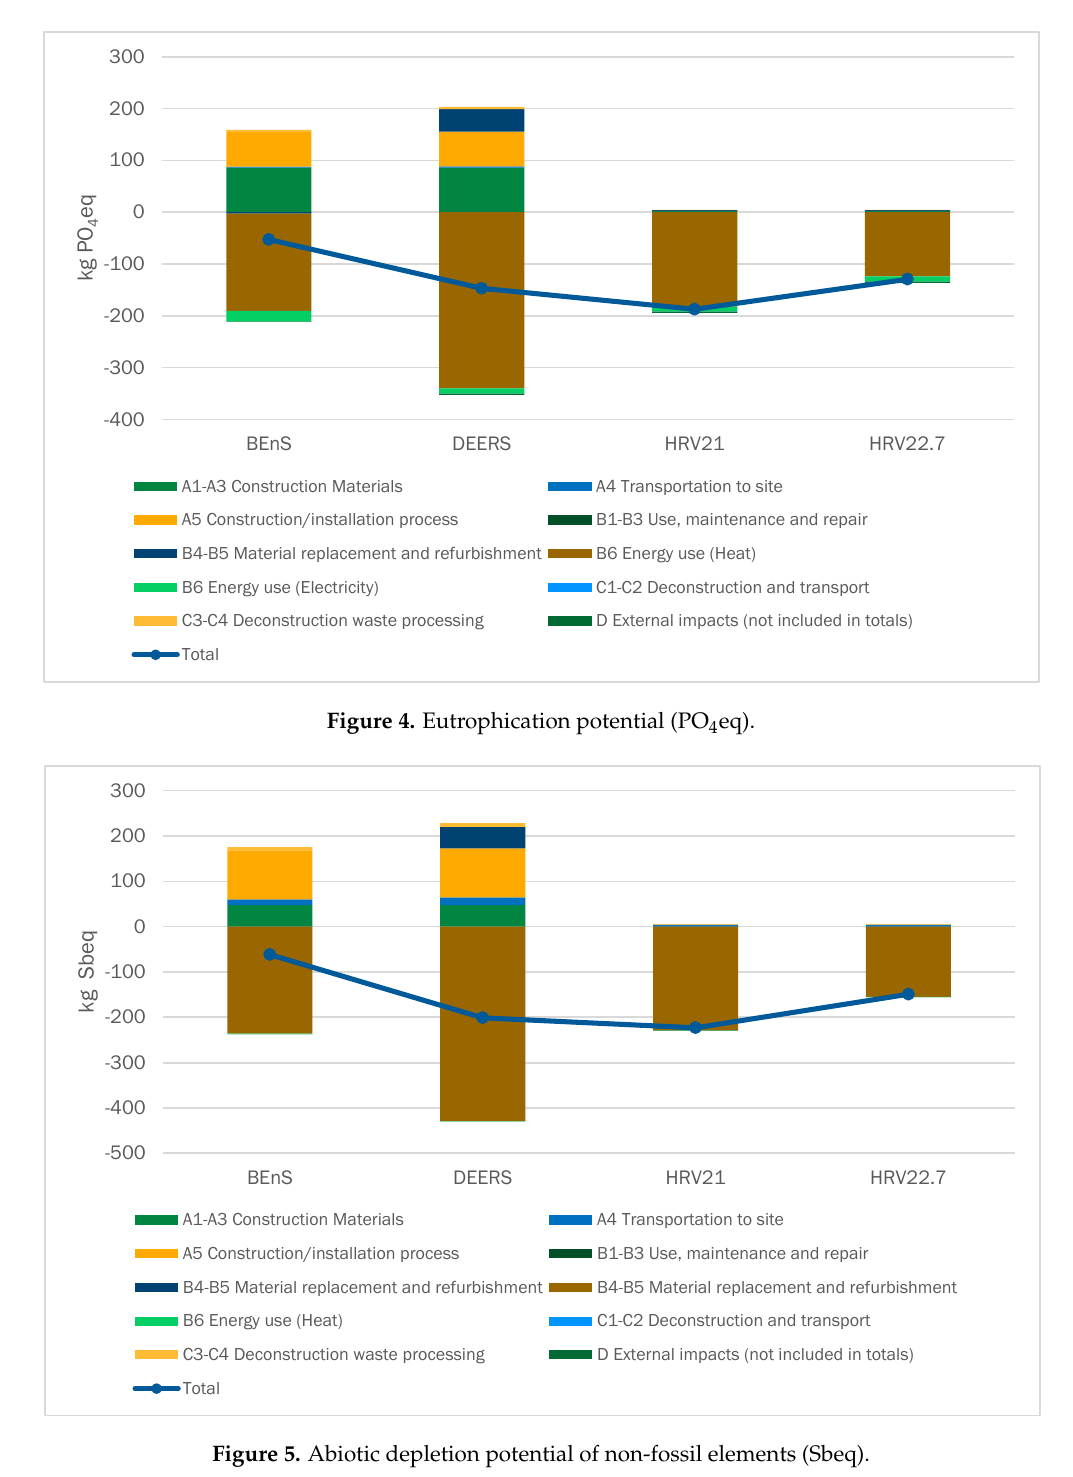
Figure 3. Acidification potential (SO 2 eq).